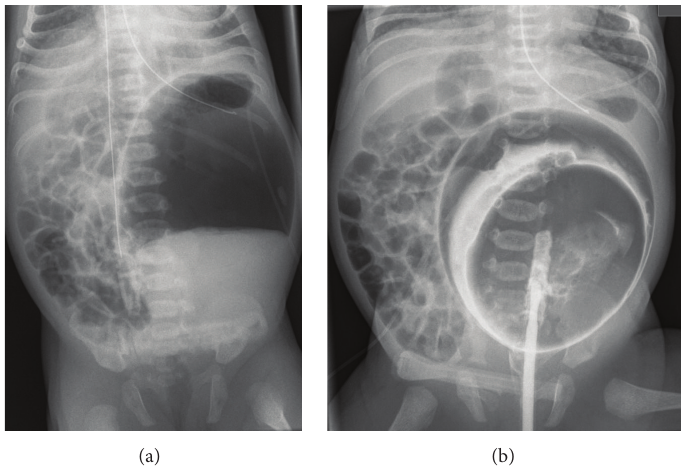
Figure 1: Upright anterior-posterior abdominal X-ray showing a big cystic lesion in the left hemiabdomen with complex contents (a); supine anterior-posterior abdominal X-ray after contrast enema (b).